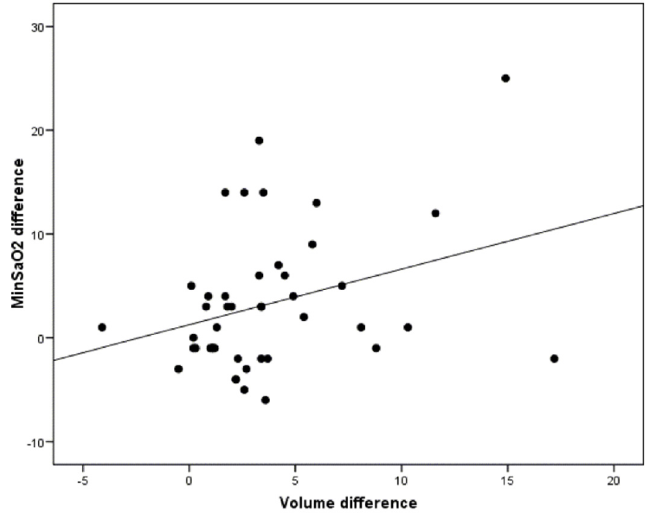
Figure 9. Correlation between the changes in minimum oxygen saturation after MAD titration and the volumetric changes of the upper airway according to the OSA severity ( p = 0.033). However, the correlation between a greater increase in the upper airway volume and the arousal index reduction was not statistically significant (r = − 0.25; p = 0.198) (Figure